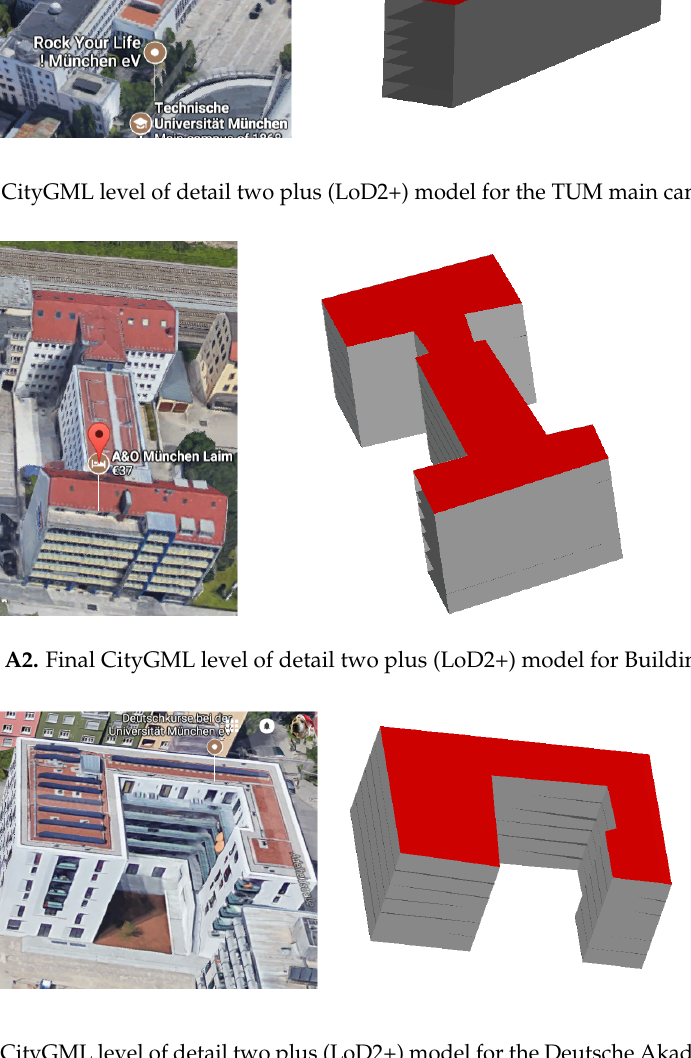
Figure A3. Final CityGML level of detail two plus (LoD2+) model for the Deutsche Akademie